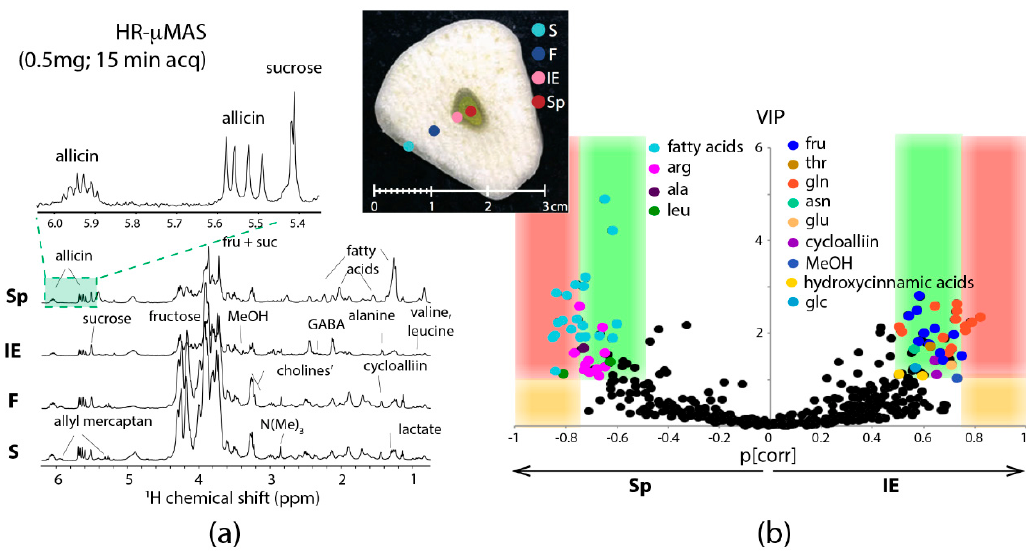
Figure 5. ( a ) 1 H HR- µ MAS NMR spectra of the four regions of a garlic clove tissue at 500 MHz spinning at 4000 Hz. The inserted photo displays the four different anatomical regions: S skin, F flesh, IE inner epidermis and Sp sprout. ( b ) A plot comparing the two quality indicators for each variable (variable = chemical shift identified as a determined metabolite) from a discriminant analysis (OPLS-DA): the variable importance in the projection (VIP) vs the variable reliability in the model (p[corr]). The separation between the two small regions (Sp = sprout; IE = inner epidermis) within the core of a single garlic clove is evident. With OPLS-DA quality-parameters: 1 predictive component and 1 orthogonal component, R 2 X = 0.747, R 2 Y = 0.955, Q 2 = 0.828, and a p-value of the cross-validation = 0.027. Adapted with permission from [30]. Copyright (2018) American Chemical Society.